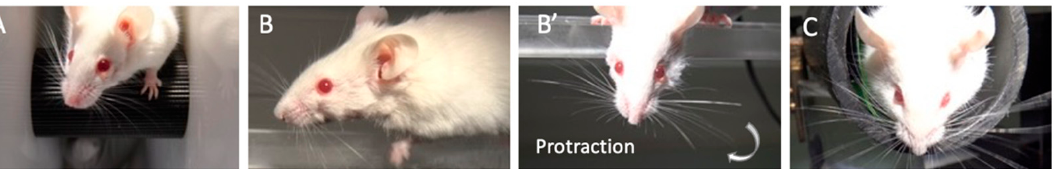
Figure 1. Modality for assessing vibrissae movement. ( A ) Video on Rota Rod; ( B ) and ( B’ ) video on a plexiglass bar; ( C ) video using a tunnel.